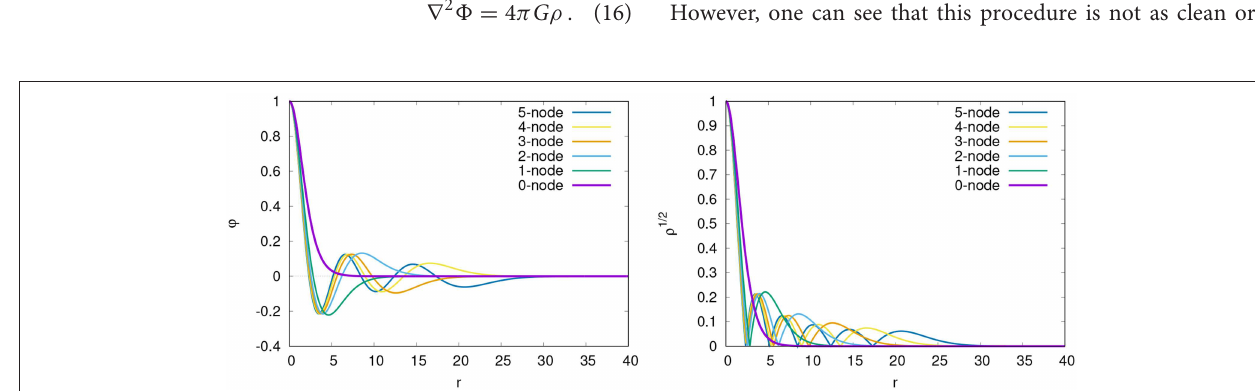
FIGURE 3 | Different equilibrium solutions of the SP system (12), see also Equations (18): the amplitude of the wavefuction ψ (0, r ) ψ ( r ) the density ρ 1 / 2 (Right) . The ground state corresponds to the node-less wavefunction, see the text for more details. = | |